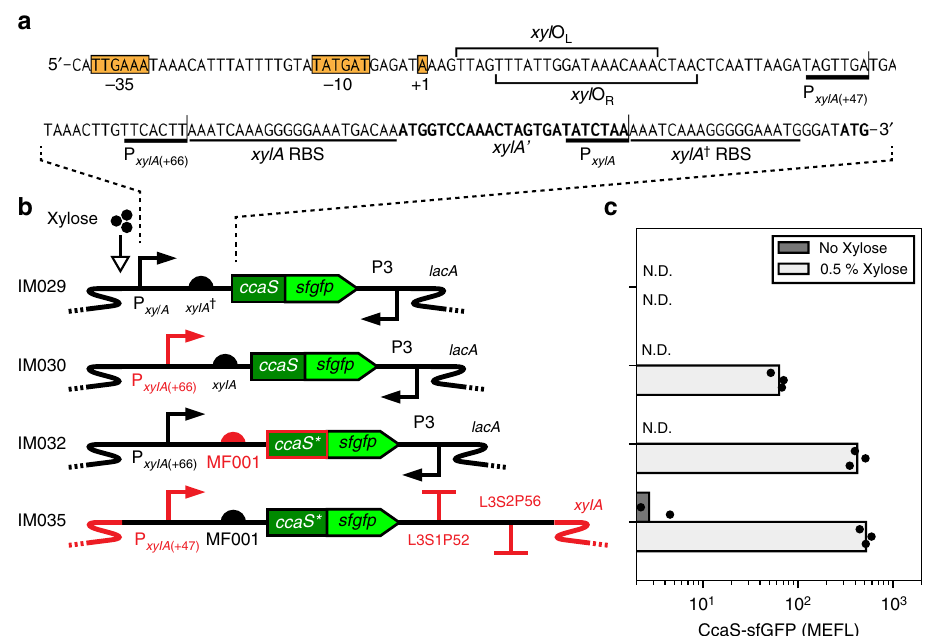
Fig. 3 Debugging and optimization of the light-sensing module. a Annotated sequence of the legacy xylose-inducible promoter P xylA in LSM v0.1, obtained from integration plasmid pAX01 18,81 . The − 35, − 10, and + 1 sites 82 and xylR operators xylO L and xylO R 83 have been previously identi fi ed. The operators are followed by an unwanted untranslated region including the xylA RBS, and a vestigial truncated xylA ORF ( xylA ’ ). A second, truncated xylA RBS ( xylA † ) is present in pAX01 to enable translation of a gene of interest placed downstream. Brackets indicate the end of the legacy P xylA promoter, as well as sequential truncations P xylA ( + 66) and P xylA ( + 47) , where problematic parts of P xylA are eliminated. The start codon of ccaS is shown at the end in bold. b Measurement and optimization of ccaS expression. We fi rst inserted ccaS-sfgfp as in ( a ). Next, we truncated P xylA to remove the vestigial elements (resulting in P xylA ( + 66) ) and placed ccaS-sfgfp directly after the xylA RBS. Then, we switched the xylA RBS with synthetic RBS MF001 (see “ Methods ” section) and recoded the initial 15 codons of ccaS . Finally, we replaced the vestigial antisense promoter P3 with synthetic terminators L3S1P52 and L3S2P56 84 , shortened the P xylA ( + 66) 5 ’ UTR (resulting in P xylA ( + 47) ), and moved the entire cassette to the xylA chromosomal locus. c Expression of CcaS- sfGFP from each engineered module shown in ( b ). Bars show the mean of three experiments run on separate days. Dots show values of individual experimental replicates. N.D.: not detected (see “ Methods ” section). Source data is available in the Source Data fi which was more than double the fl uorescence that occurred with the dramatically enhanced PCB levels were not due to higher exogenous PCB addition. Interestingly, levels of Ho1-PcyA-sfGFP enzyme expression, but likely to more ef fi cient transfer of BV from from PPM v0.3 (19,900 ± 1100 MEFL, Supplementary Fig. 8) were Ho1 to PcyA. We hypothesized that PPM v0.3 would support comparable to those of the non-fused enzymes in PPM v0.2. Thus, robust CcaSR function in B. subtilis .